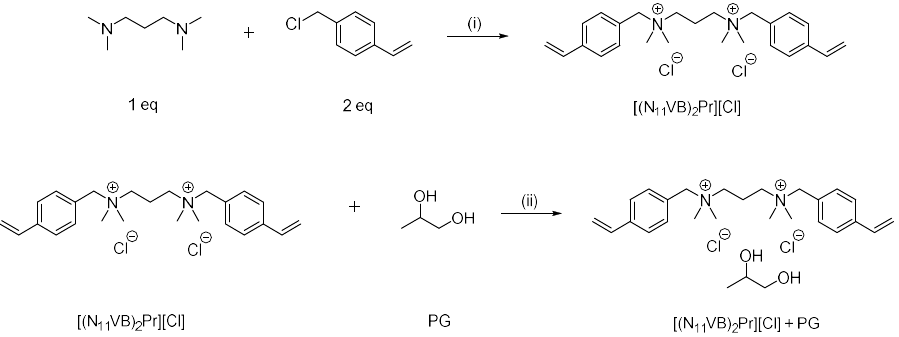
Figure 5. Reaction scheme for the synthesis of ionic liquid and preparation of its mixture with propylene glycol; ( i ) 40 °C, MeCN, 48 h; ( ii ) anhydrous methanol, stirring, evaporation. T m = 240.02 °C 1 H NMR (400 MHz, DMSO- d 6 ) δ 7.62 (s, 8H), 6.81 (dd, J = 17.7, 10.9 Hz, 2H), 5.96 (d, J = 17.7 Hz, 2H), 5.38 (d, J = 11.1 Hz, 2H), 4.75 (s, 4H), 3.51–3.26 (m, 6H). 13 C NMR (101 MHz, DMSO- d 6 ) δ 139.32, 136.33, 133.89, 127.99, 126.98, 116.68, 66.77,